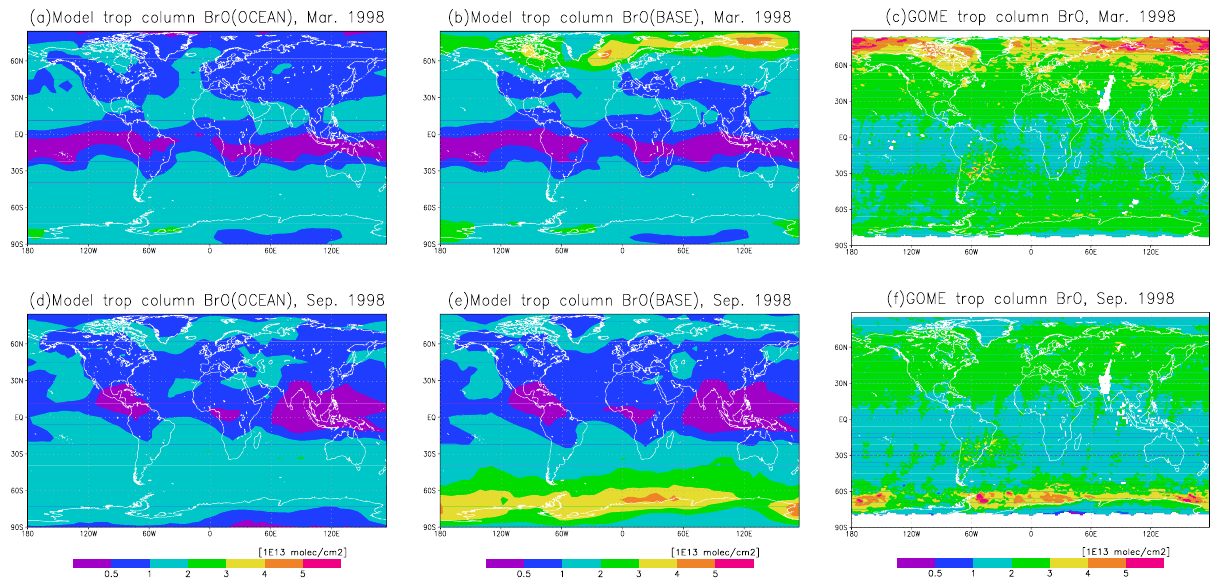
Fig. 1. Comparisons of simulated tropospheric column BrO from OCEAN run ( a and d ) and BASE run ( b and e ) and retrieved tropospheric column BrO ( c and f ) in March and September of year 1998, respectively. Note that the model data represent BrO during daytime (local